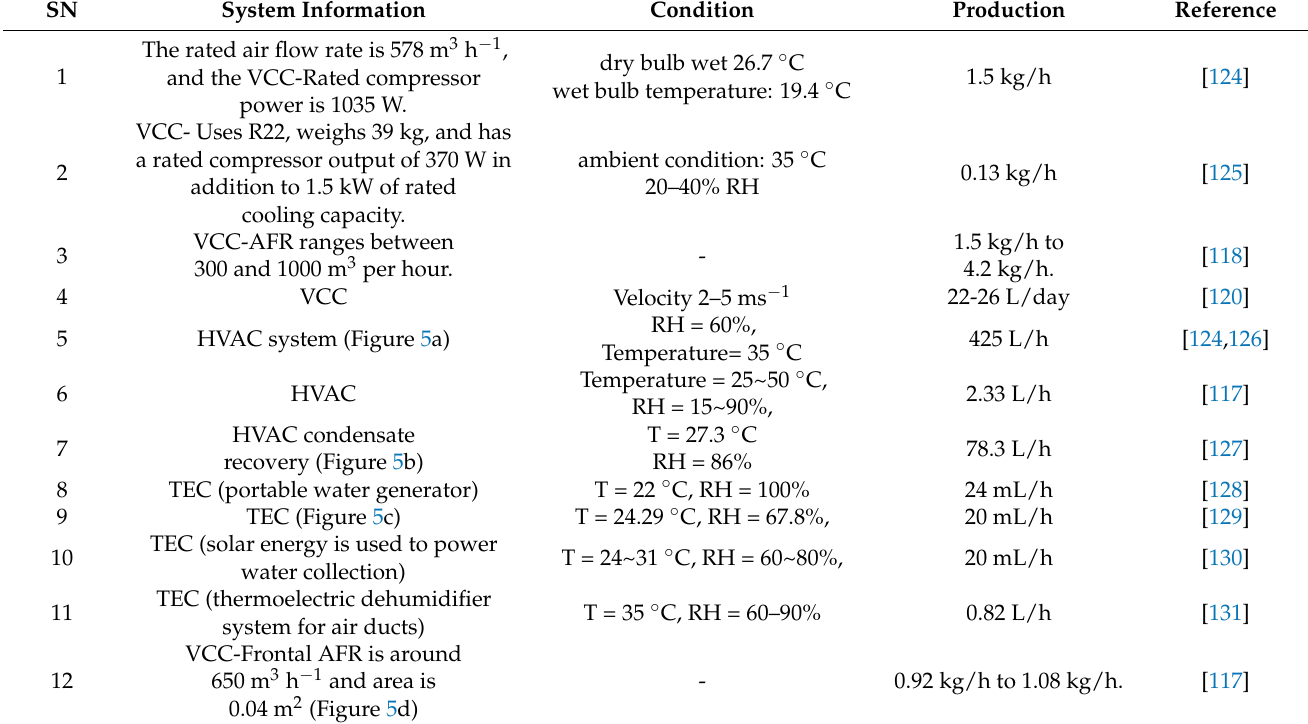
Table 4. Comparison of various types of fog water harvesting.